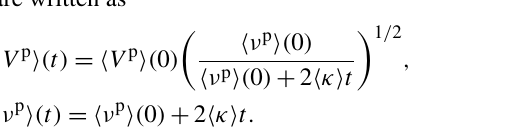
Figure 5. The length-scale counterpart of Fig. 4 representing the predictability-error length-scale fields (cid:101) L p (nature) and L p (numerical model) in panels (a, c) (in panels b – d ). The length scales are diagnosed from the diffusion coefficients from the formula L = by the grid spacing δx . Panels (a) and (b) are computed from the PKF, while (c) and (d) are estimated from the same large ensemble of forecasts as considered in Fig. 4. Fields are represented for times from t = 0 to t = T and represented each 0 . 1 T